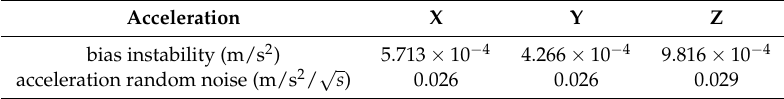
Table 5. The accelerometer performance parameters.